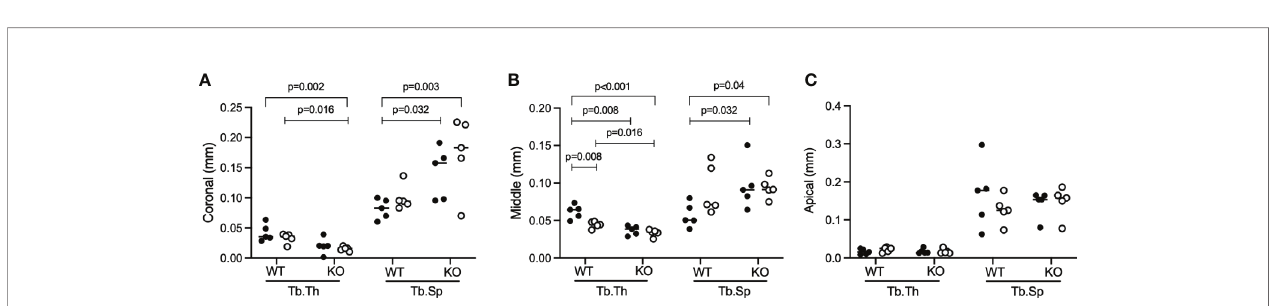
FIGURE 3 | Trabecular thickness (TbTh) and trabecular separation (TbSp) in the extraction sockets. FasL KO mice shows lower Tb.Th and higher Tb.Sp compared to WT mice in the coronal (A) and middle part (B) while no differences were observed in the apical part (C) . Statistical analysis was based on Mann ‐ Whitney U test, P values are given where was found signi fi cant differences. The bars show the median with female (black dots) and male mice (white dots) are distributed in the dot plots.